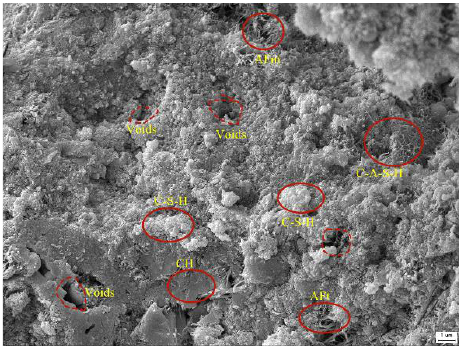
Figure 10. SEM photograph of 15% ferrochrome slag powder.